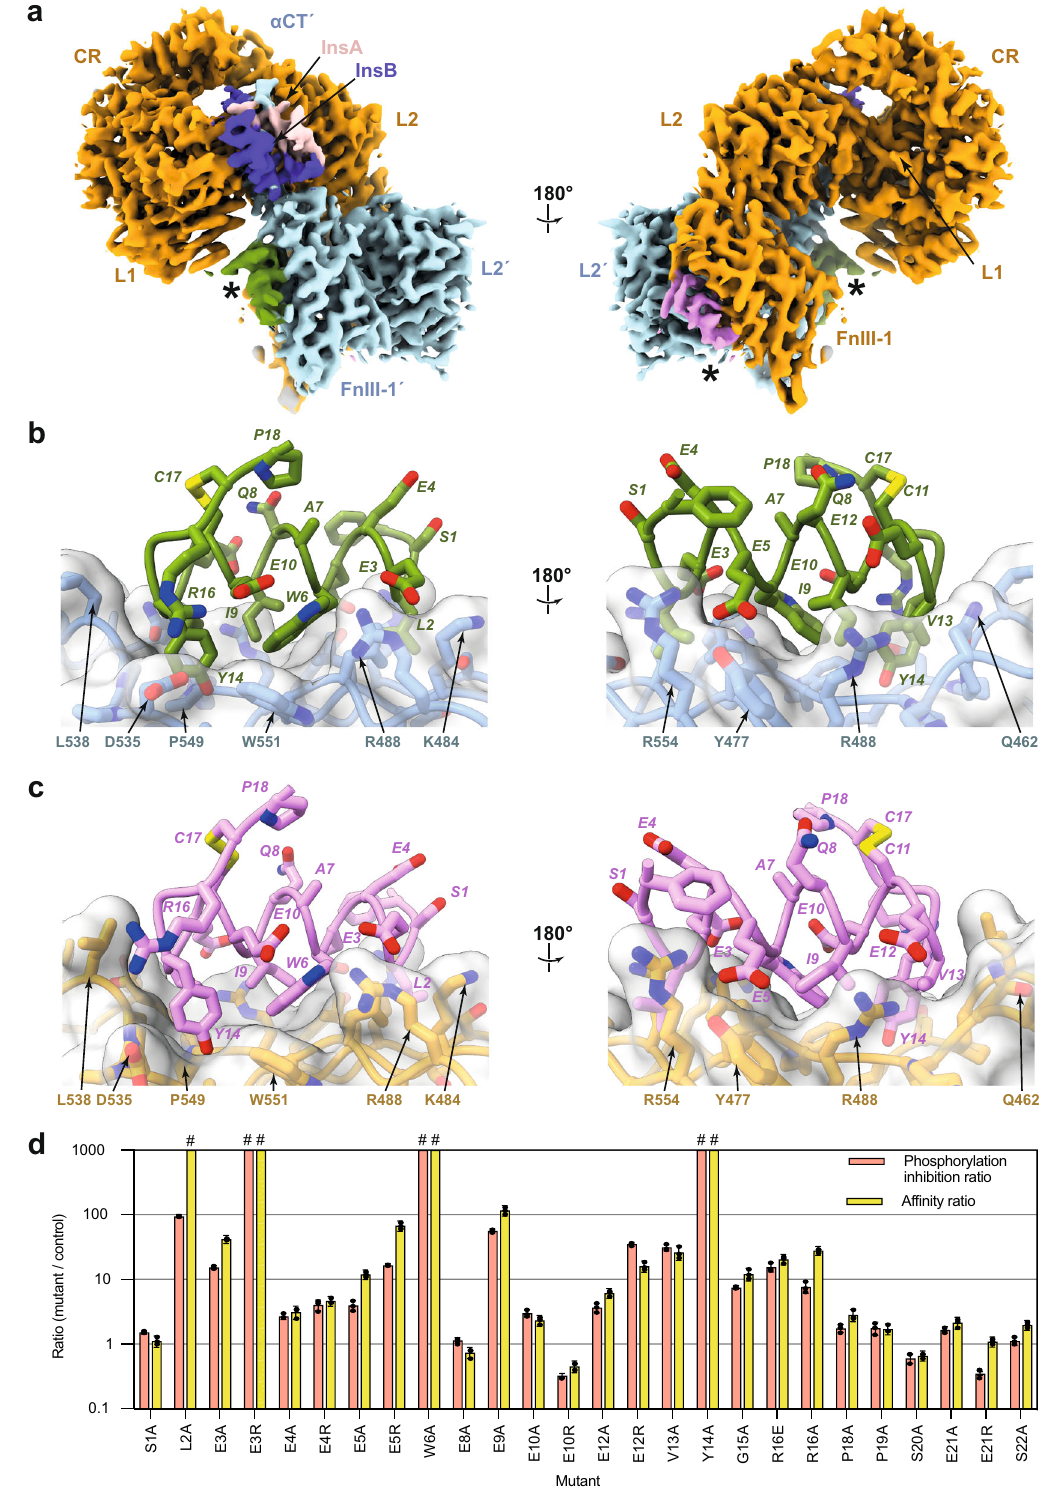
b and c ,oxygenatomsareinred,nitrogenatomsinblueandsulfuratomsinyellow. d Relative af fi nity ratio ( K i (mutant) / K i (control) ) and relative phosphorylation inhibition ratio (IC50 (mutant) /IC50 (control) ) of mutant peptides. Mutations indicated are with respect to the control peptide (= IM172N22 devoid of N-terminal phenylacetyla- tion). Error bars re fl ect standard error of the mean of each ratio, based on n =3 independent technical replicates and with aberrant measurements omitted as indicated in the associated Source Data fi le. #: ratio >4000.